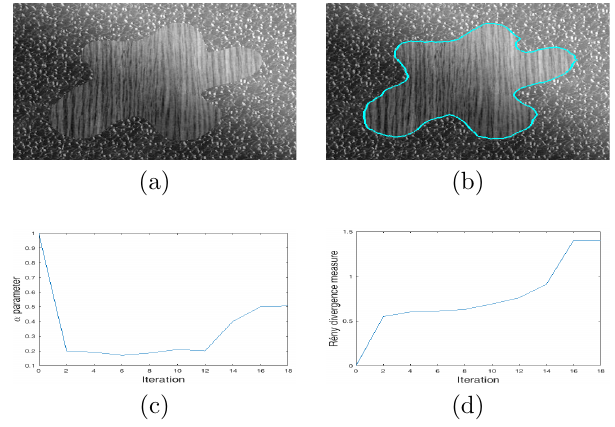
Figure 3. (a) Synthetic image, (b) our segmentation result, (c) evolutoin of the α parameter along the segmentation process, (d) evolution of the Reny divergence measure along the segmentation